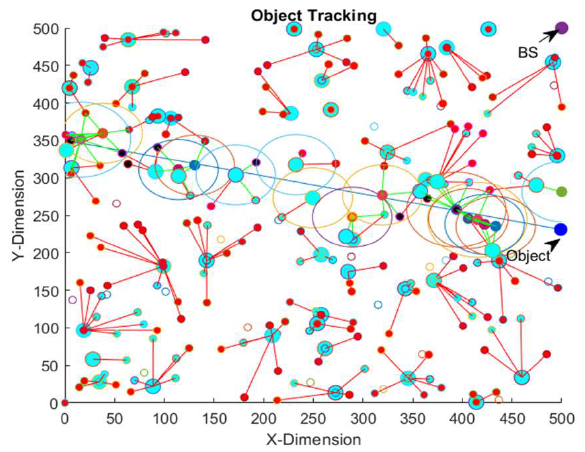
Figure 6. Object tracking in WSN visualization for EEODTF and object trajectory 1.